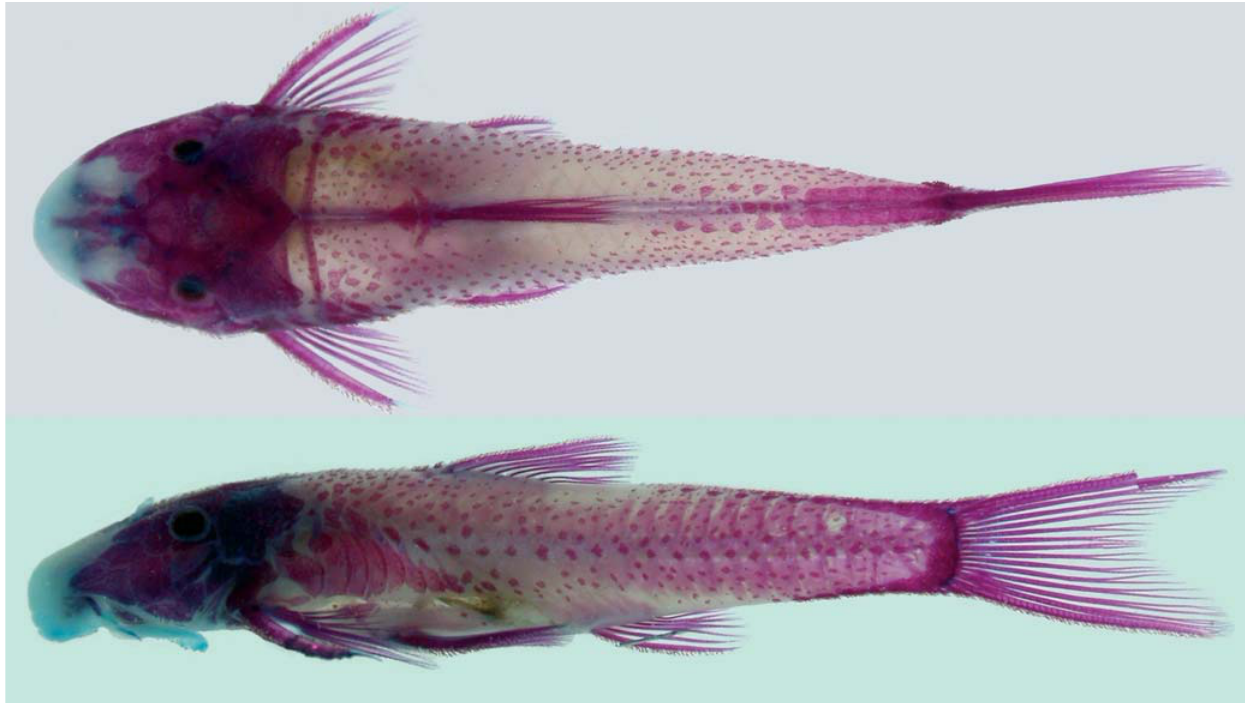
Fig. 2. Gymnotocinclus anosteos , cleared and stained paratype, MCP 41726, male, 40.5 mm SL, collected with the holotype.